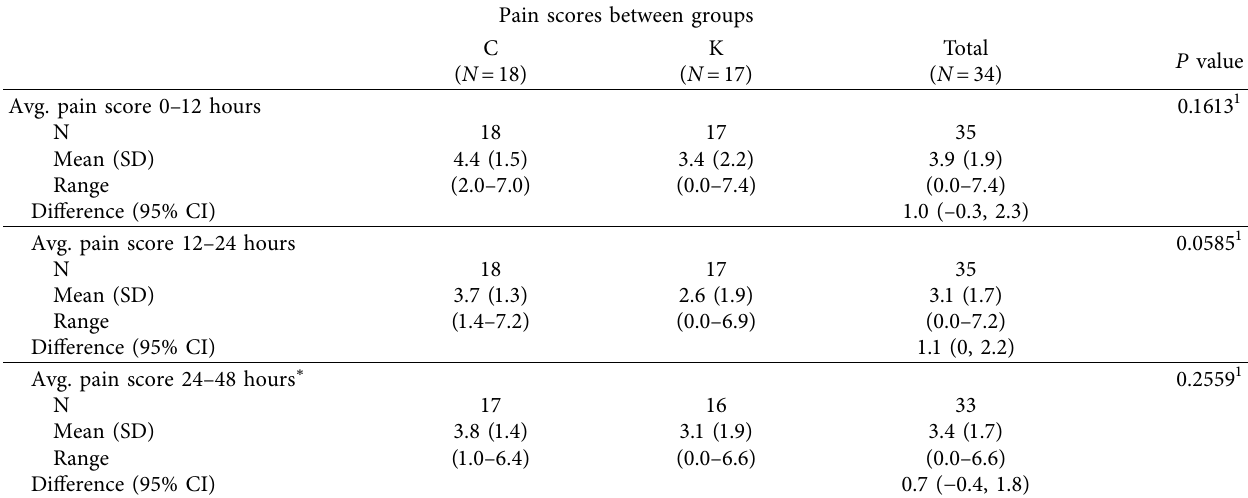
Table 4: Pain score data between the